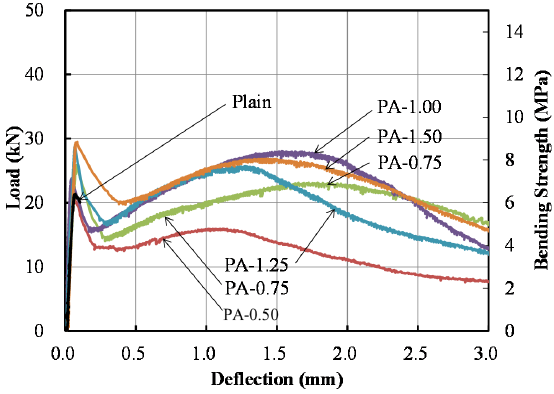
Figure 5. Load ‐ deflection curves of flexural bending tests.